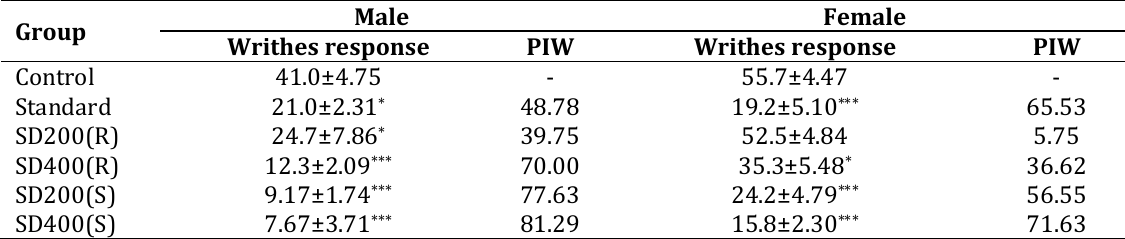
from control at *p<0.05,